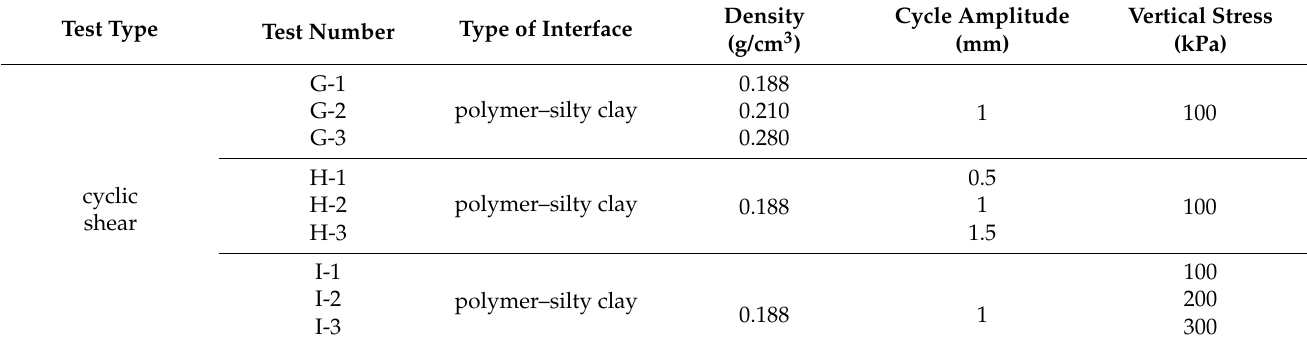
Table 5. Dynamic shear test schemes of polymer–soil